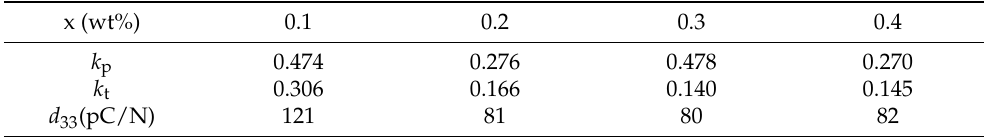
Table 2. Electromechanical coupling coefficient of KNN-xBi 2 O 3